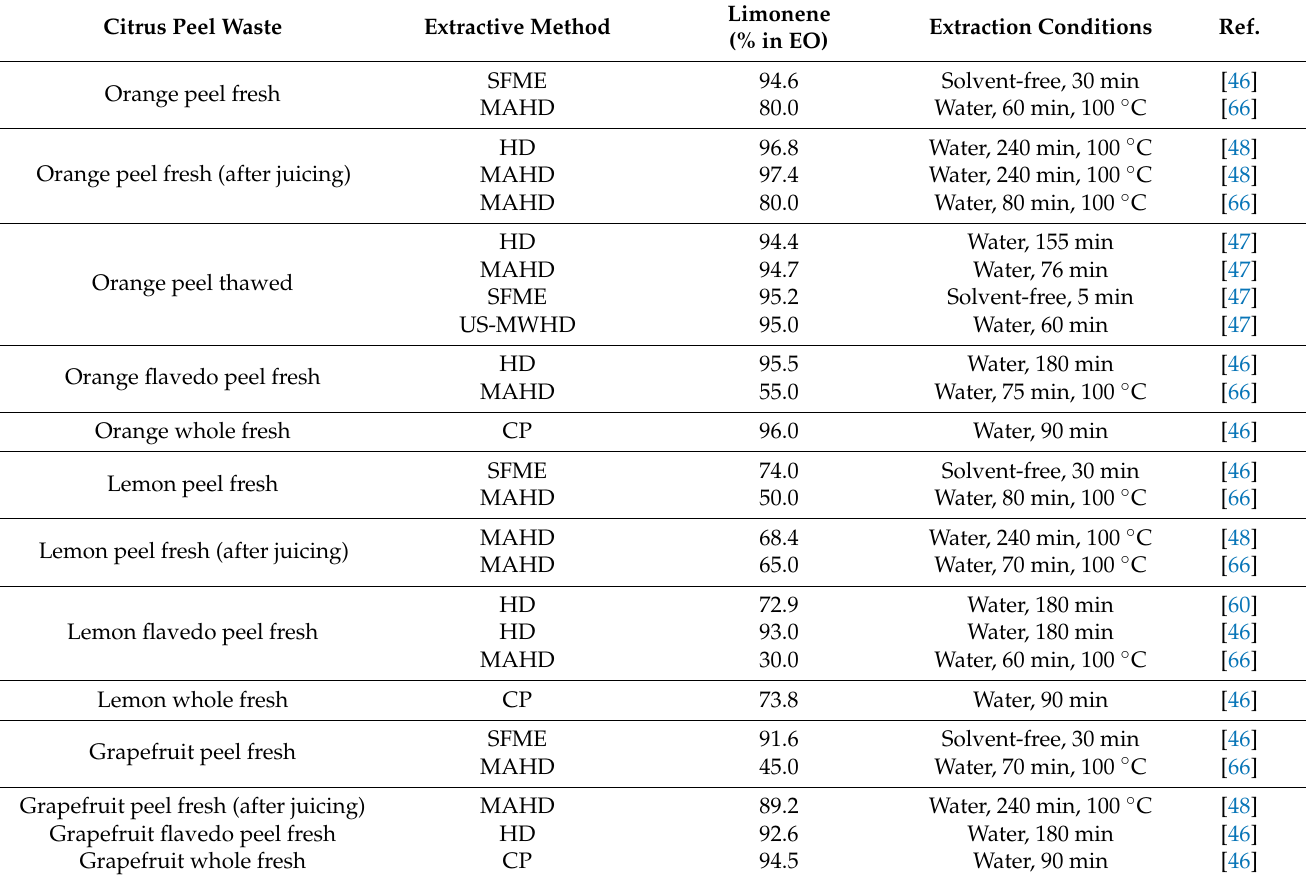
Table 1. Comparison of different extraction methods for the recovery of